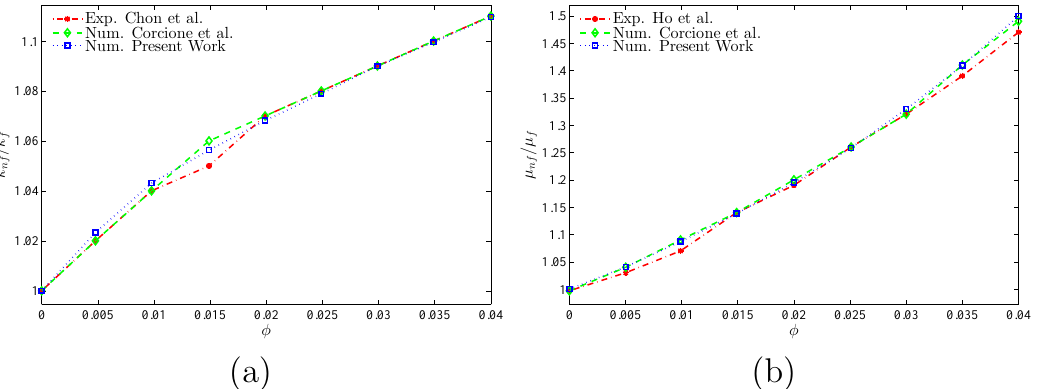
Figure 5. Comparison of ( a ) the thermal conductivity ratio with the literature works of Chon et al. [49] and Corcione et al. [50] and ( b ) the dynamic viscosity ratio with the studies of Ho et al. [51] and Corcione et al.